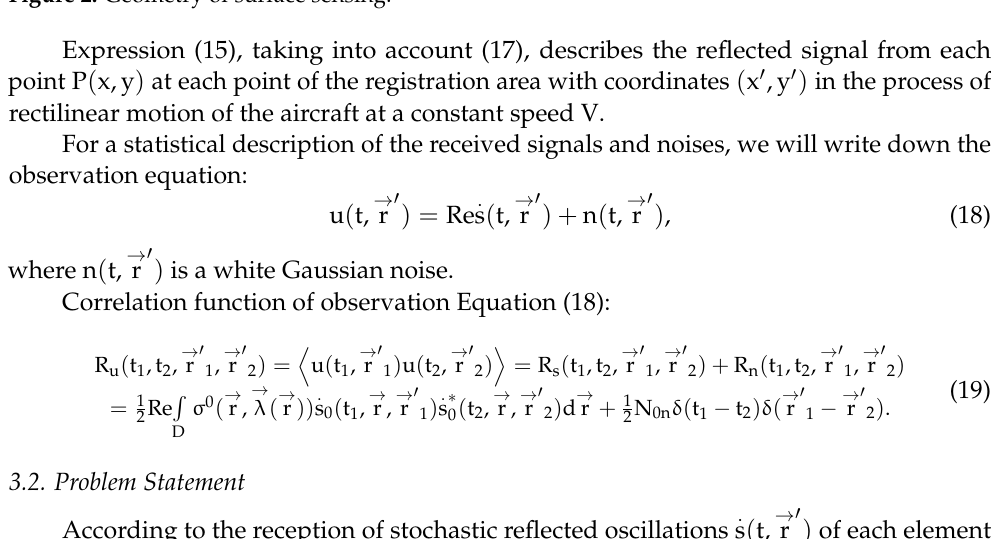
Figure 2. Geometry of surface sensing.